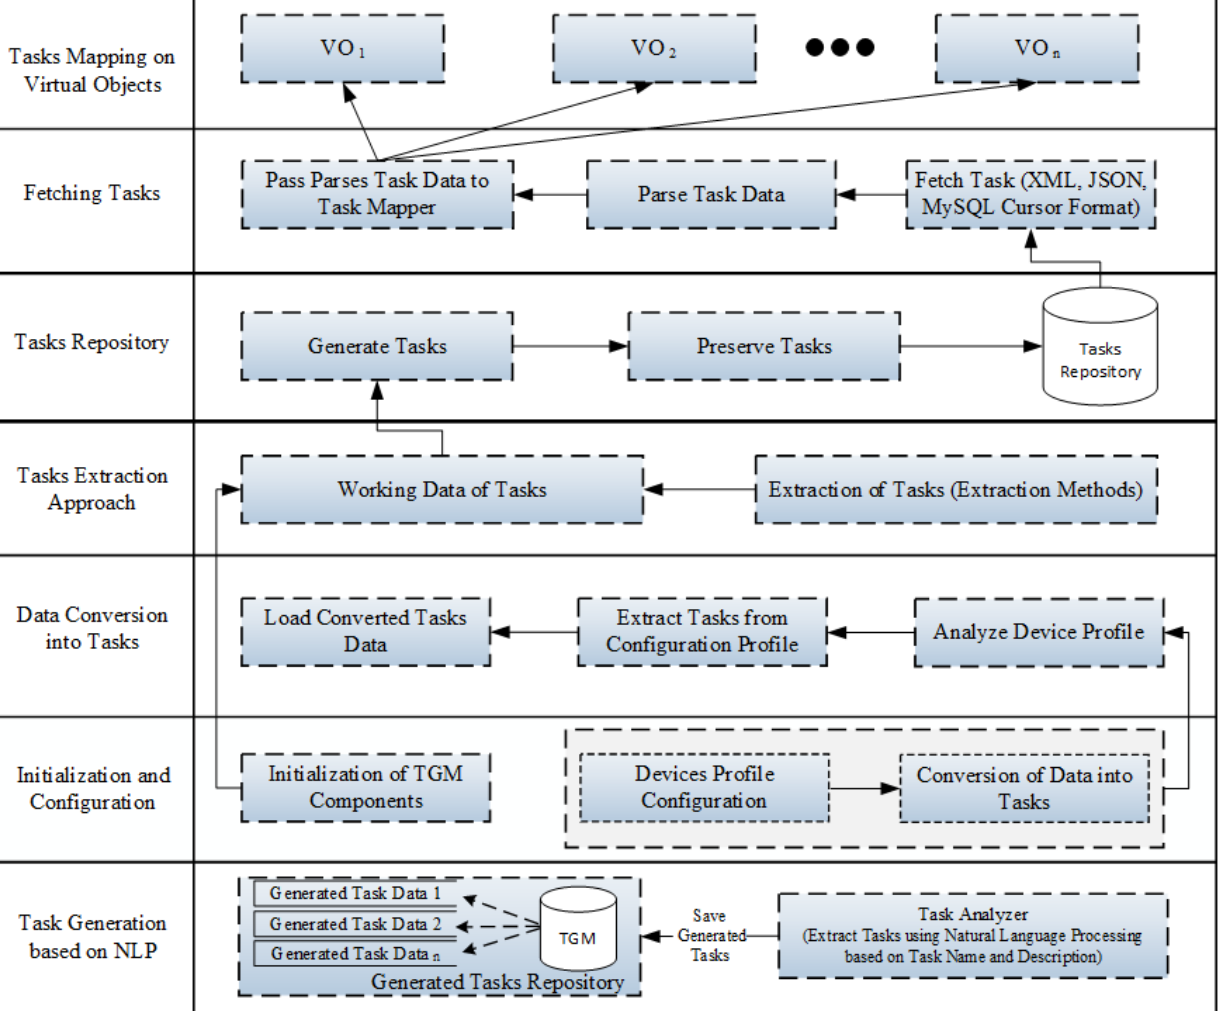
Figure 3. Basic flow of automatic generation of health